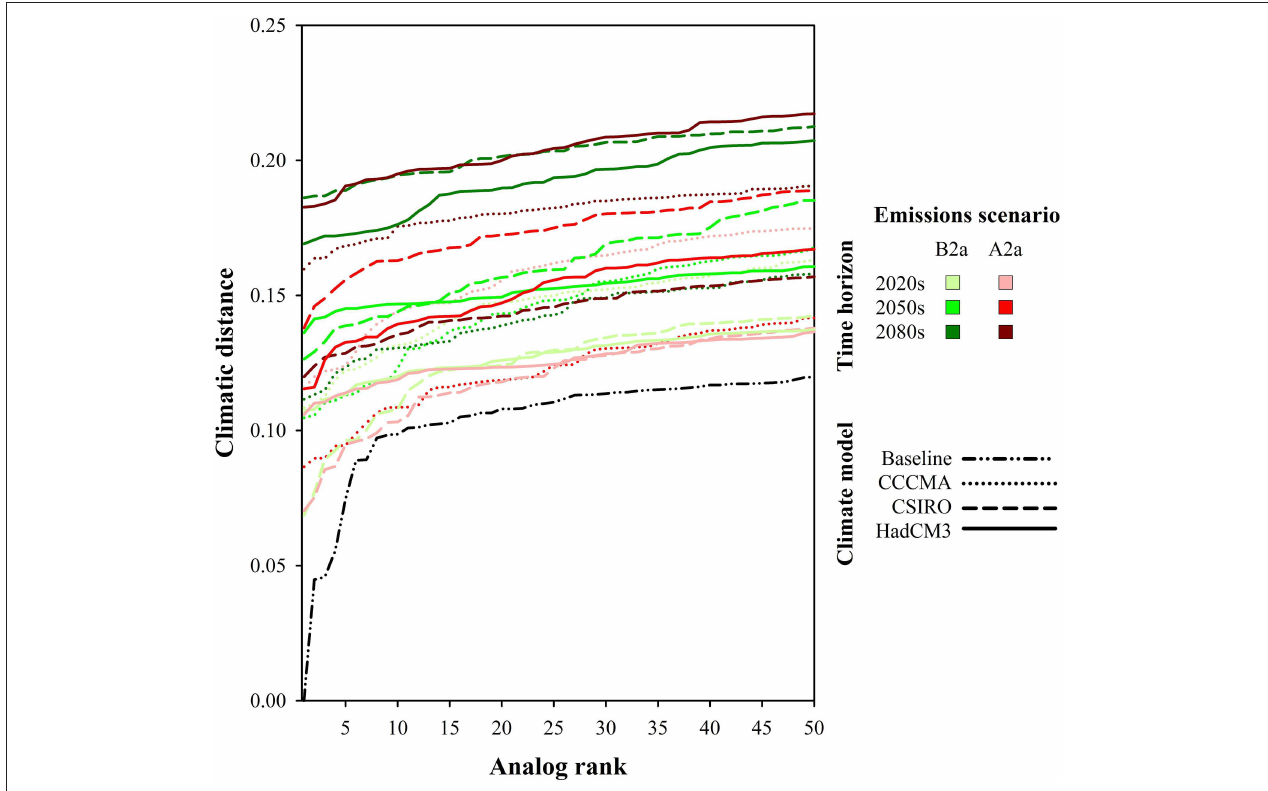
FIGURE 5 | Distribution of climatic distances between the 50 closest climate analog locations and the projected conditions for the baseline site for 18 climate change scenarios, and a baseline scenario. A horizontal line and a low climate distance value would indicate that the 50 analog locations have almost identical climate